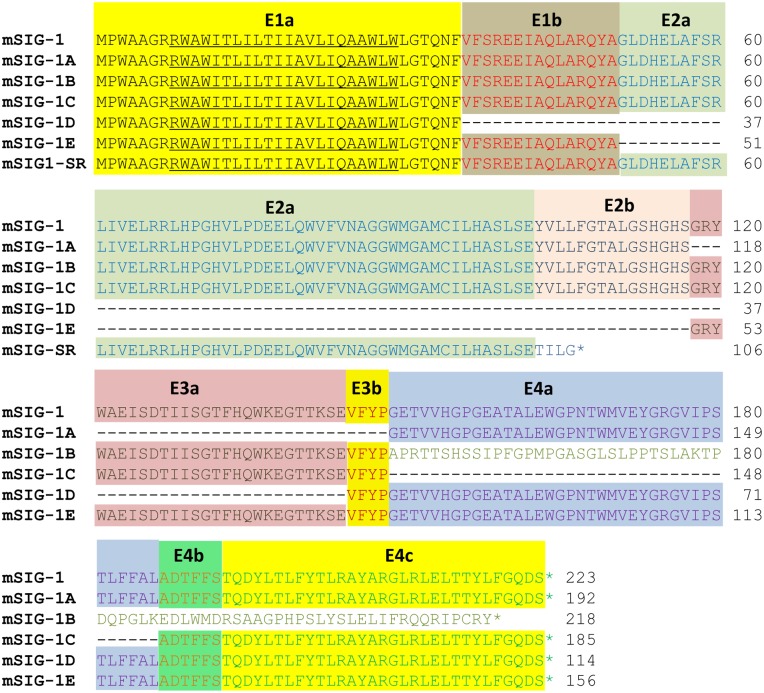
Alignment of the predicted amino acid sequences of the mouse Sigmar1 splice variants.The predicted amino acid sequences were aligned using ALIGN progrom in Vector NTI (Invitrogen). The exon assignment for the predicted amino acids is shown by colored letters and backgrounds. The transmembrane domain is underlined. The number of amino acids is list on the right. *: stop codon. The nucleotide and deduced amino acid sequences of the mouse sigma1 receptor 1a (mSIG-1A), mSIG-1B, mSIG-1C, mSIG-1D and mSIG-1E have been deposited in the GenBank database with Accession numbers: AY390764, AY390765, AY390766, AY390767 and AY390768, respectively.